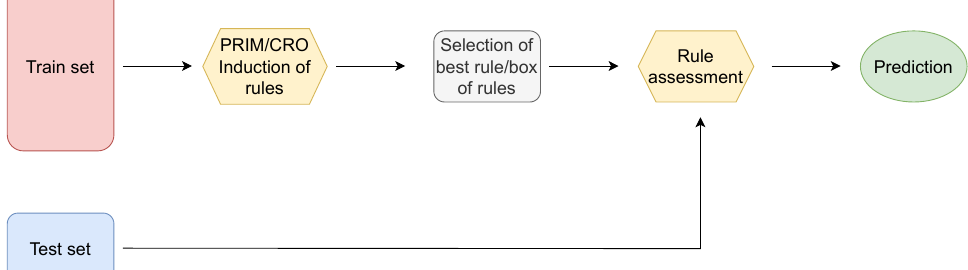
Figure 12. Flow diagram of the proposed methodology in which the induced rules are used as pre-